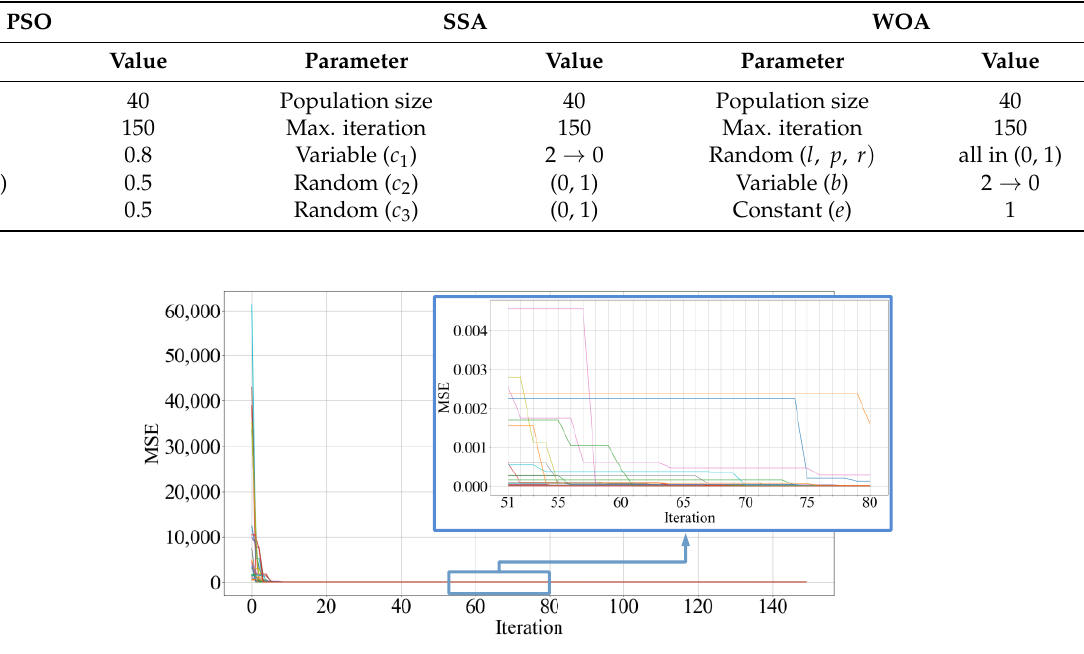
Figure 11. Convergence curves for 24 h for the PSO method.